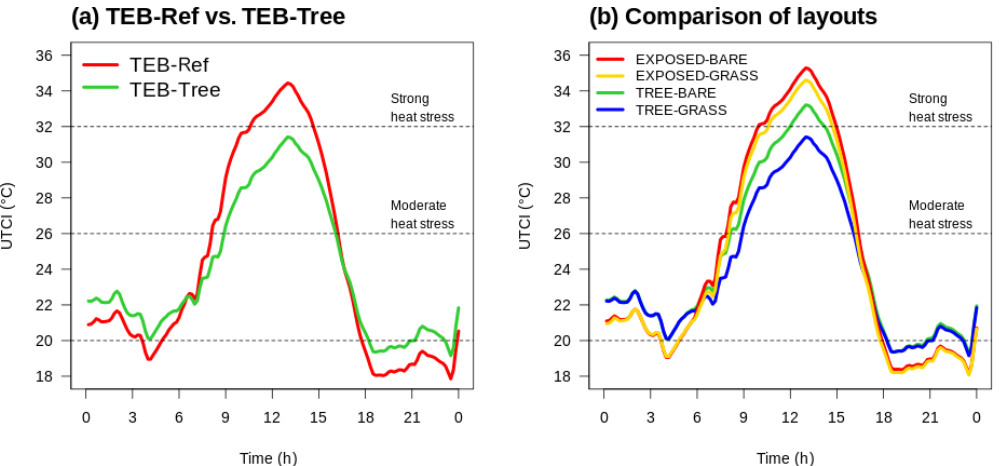
Figure 5. (a) Comparison of UTCI simulated in the courtyard by TEB-Ref (red line) and TEB-Tree (green line) for TREE-GRASS configu- ration; (b) comparison of UTCIs simulated by TEB-Tree for four different courtyard